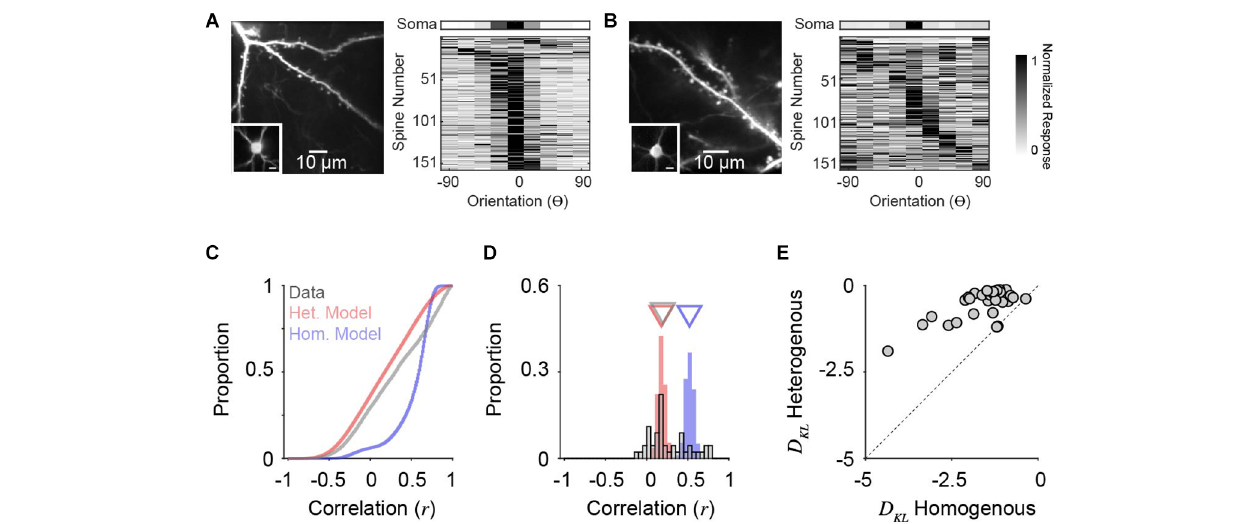
FIGURE 5 | Orientation tuning diversity of dendritic spine populations in ferret V1 match simulations with correlated, heterogeneous input populations. (A) Two-photon standard deviation projection of example dendrite and spines recorded from a single cell (left). Inset: Two-photon standard-deviation projection of corresponding soma. The scale bar is 10 microns. Orientation tuning of soma (top) and all visually-responsive dendritic spines from this single cell ( n = 159) are shown (right). Spine responses are normalized peak ∆ F/F. Orientation preferences are shown relative to the somatic preference (aligned to 0 o ). (B) Same as in (A) for another example cell ( n = 162 visually-responsive spines). (C) Cumulative distributions of tuning correlation between individual dendritic spines or simulated synaptic inputs with corresponding somatic tuning or decoder output. Shown are correlations of simulations of homogenous (blue) or heterogeneous (red) input populations, compared to empirical data (gray). (D) Distributions of average tuning correlation between synaptic input and somatic output across measured cells ( n = 45). Also shown are distributions of average tuning correlation for simulated cells. Triangles denote median values for each distribution. (E) Comparison of Kullback-Leibler divergence (D KL ) between data and each model type. Each data point represents an individual cell’s population of dendritic